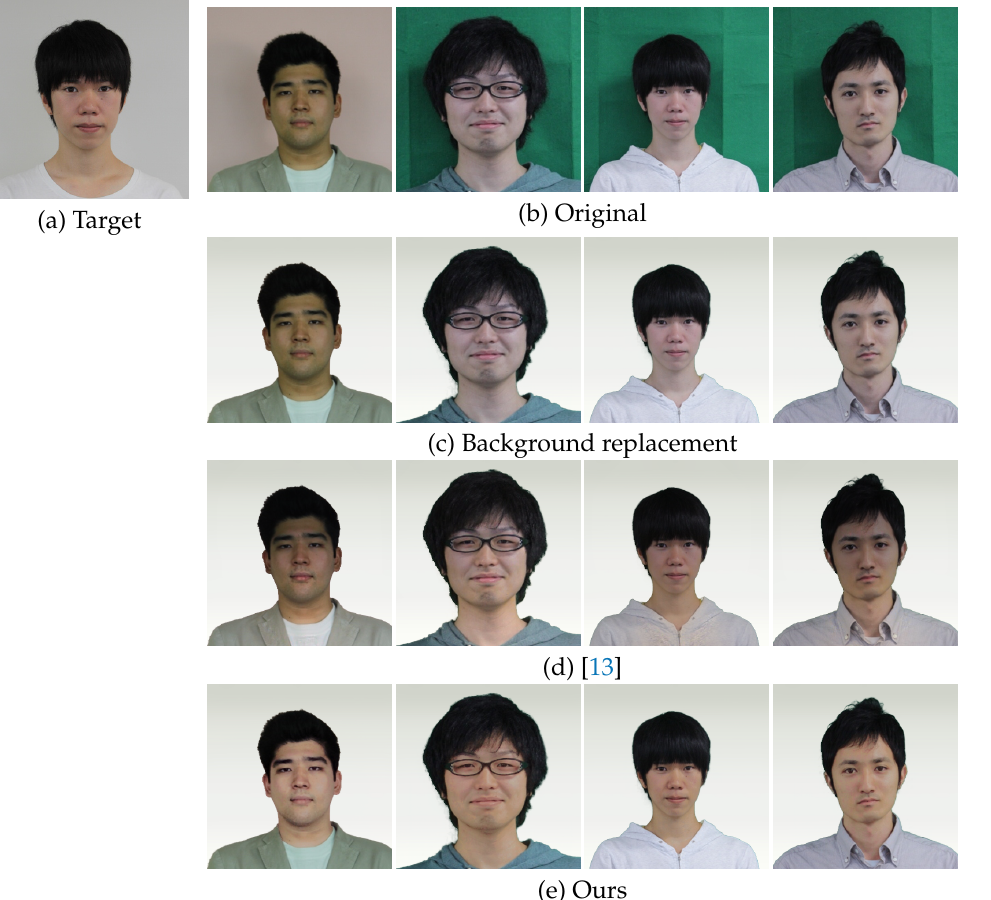
Figure 14. Comparison with the background replacement result and [13]. ( a ) target facial skin color image; ( b ) original images; ( c ) the background replacement result as a example; ( d ) the style transfer result by [13]; and ( e ) the yearbook style photo using our